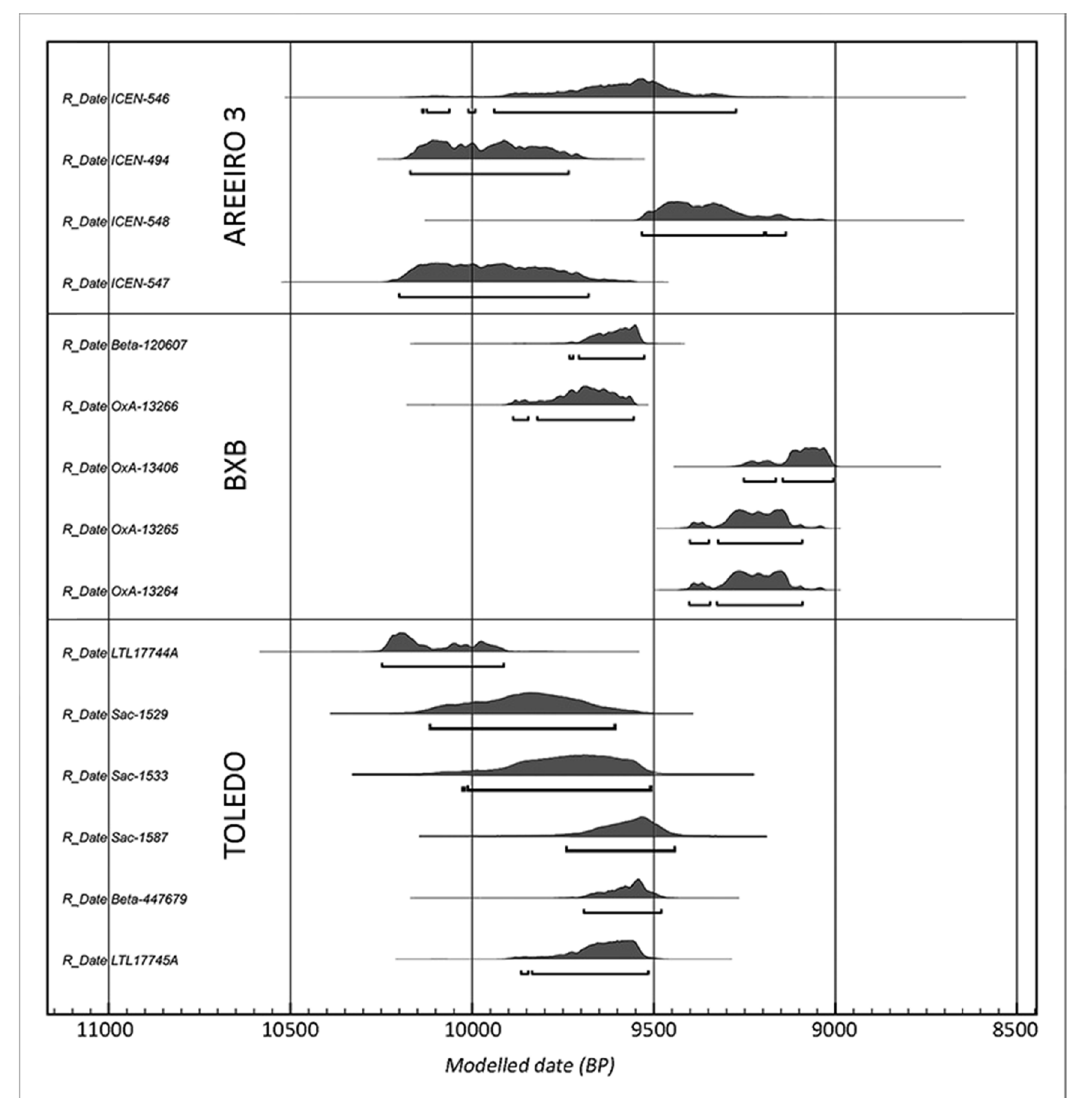
calibrated with OxCal 4.4, using the atmospheric curve IntCal20 ( Reimer et al., 2020 ) . Marine samples were calibrated using the Marine20 curve ( Heaton et al., 2020 ) and regional Δ R westcoast of 95 ± 15 14C years BP ( Soares et al., 2016 ) . The proportion of marine protein intake from the human bone sample was estimated from the measured δ 13 C value with an assumed uncertainty of ± 10% ( Arneborg et al., 1999; Richards & Hedges, 1999 ) . The adopted endpoint values for marine ( 100% ) and terrestrial ( 100% ) diets in Mesolithic Atlantic Iberia determined by Cubas et al., 2018 are, respectively, − 12.0 ± 0.6 ‰ to − 20.8 ± 1.0 ‰